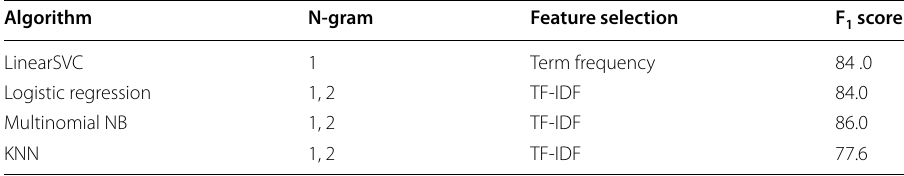
Table 4 Baseline results for four algorithms used in this